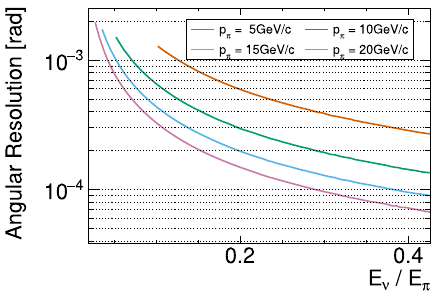
Fig. 3 Angular resolution on the tagged neutrino as a function of the fraction of the π ± energy transferred to the neutrino for different π ± momenta